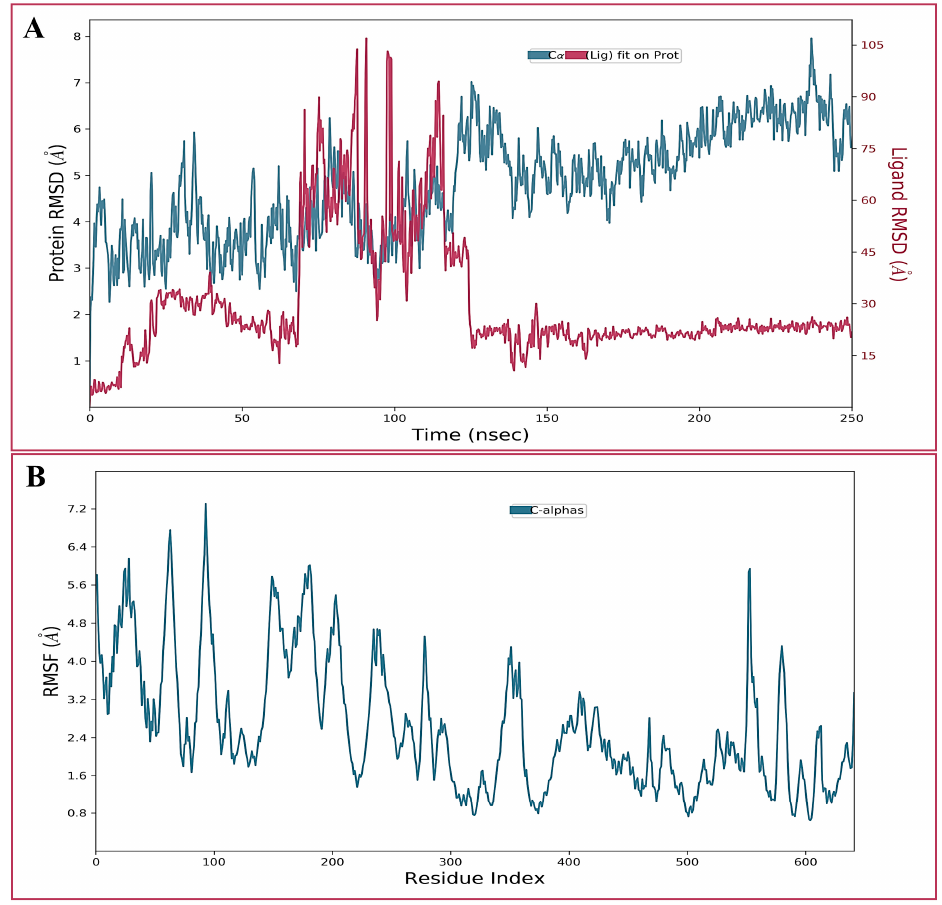
Figure 2. ( A ) The root-mean-square deviations (RMSD) of C α atoms of penicillin-binding protein 2a in complex with isoeugenol during 250 ns MD simulation. ( B ) The root-mean-square fluctuation (RMSF) of C α atoms of penicillin-binding protein 2a in complex with isoeugenol during 250 ns MD simulation.